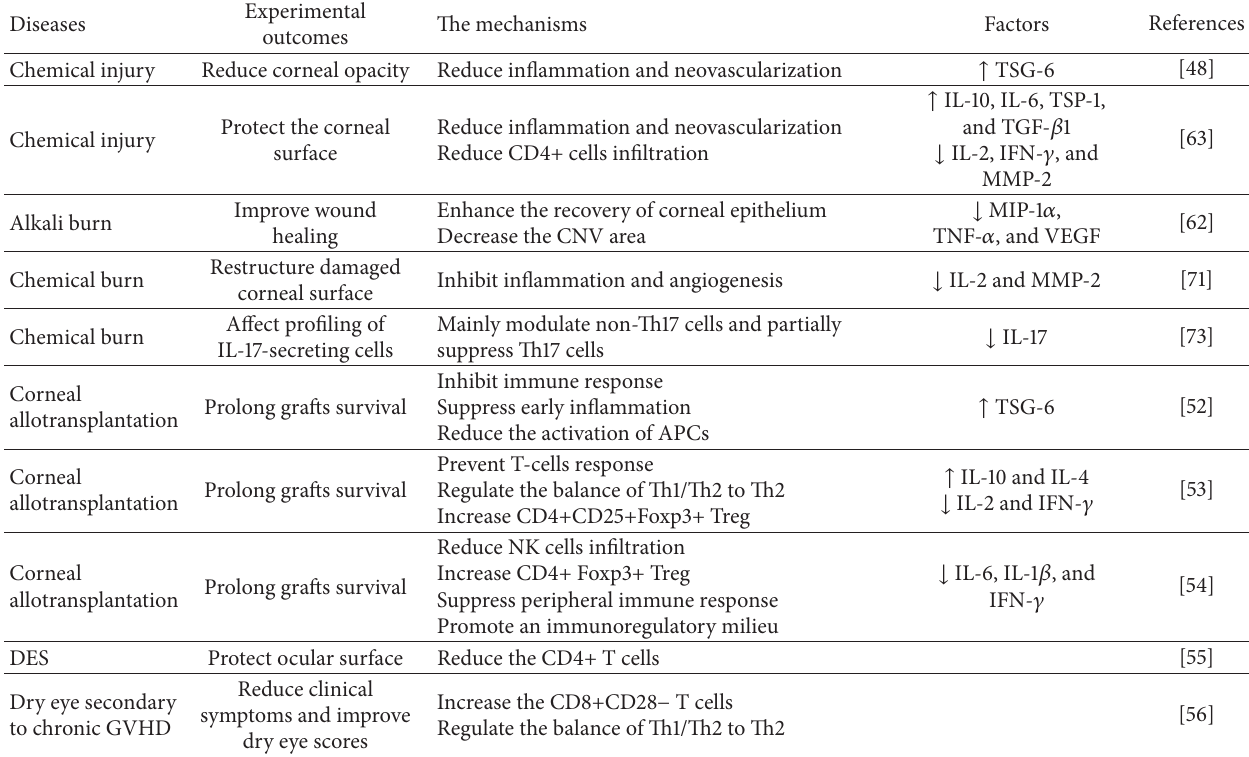
Table 1: Experiments of MSCs in ocular surface